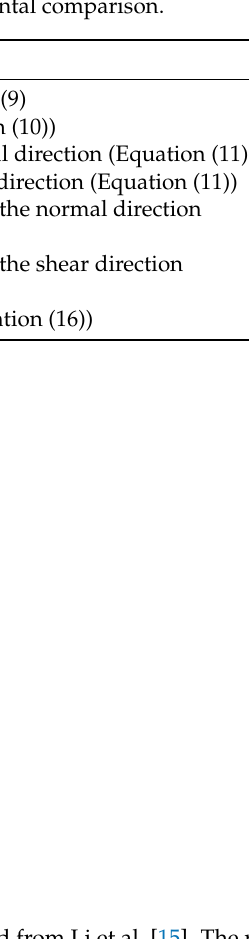
Figure 5. Drying geometry of water-swollen cellulose beads replotted from Li et al. [15]. The radii are normalised against the initial radius of the bead.